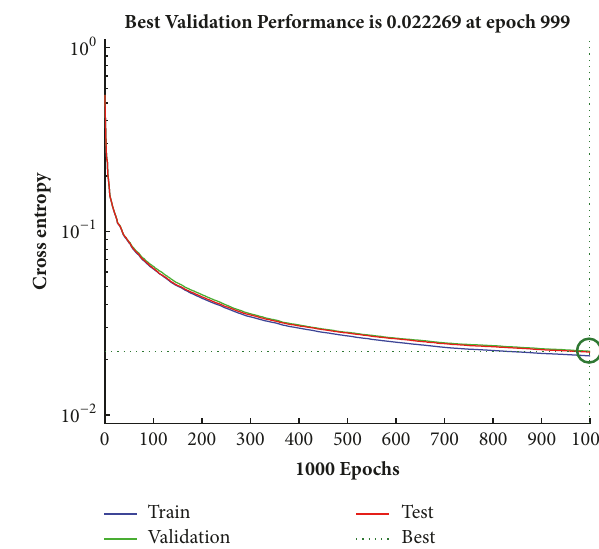
Figure 18: Training error curve of the neural network.